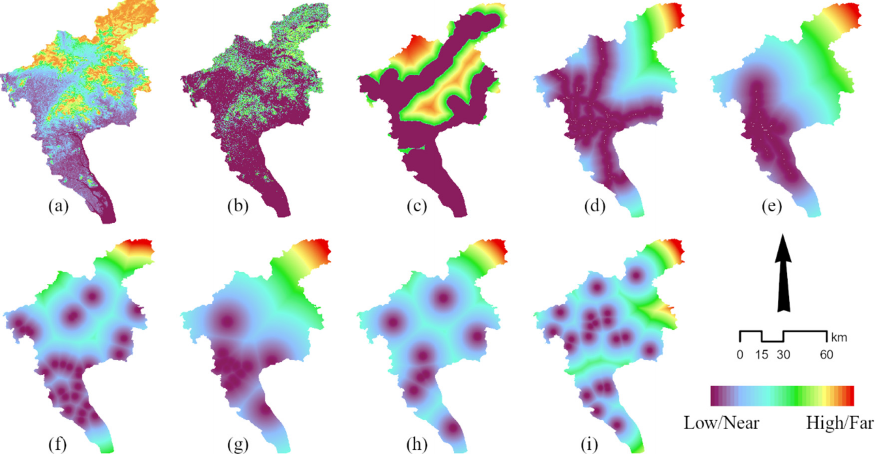
Figure 3. Maps reflecting the spatial environment for driving urban growth from 1995 to 2015 in Guangzhou. ( a ) Digital elevation model (DEM), ( b ) Slope, ( c ) Proximity to river, ( d ) Proximity to highway, ( e ) Proximity to subway, ( f ) Proximity to port, ( g ) Proximity to municipal development center, ( h ) Proximity to district development center, and ( i ) Proximity to town development center.